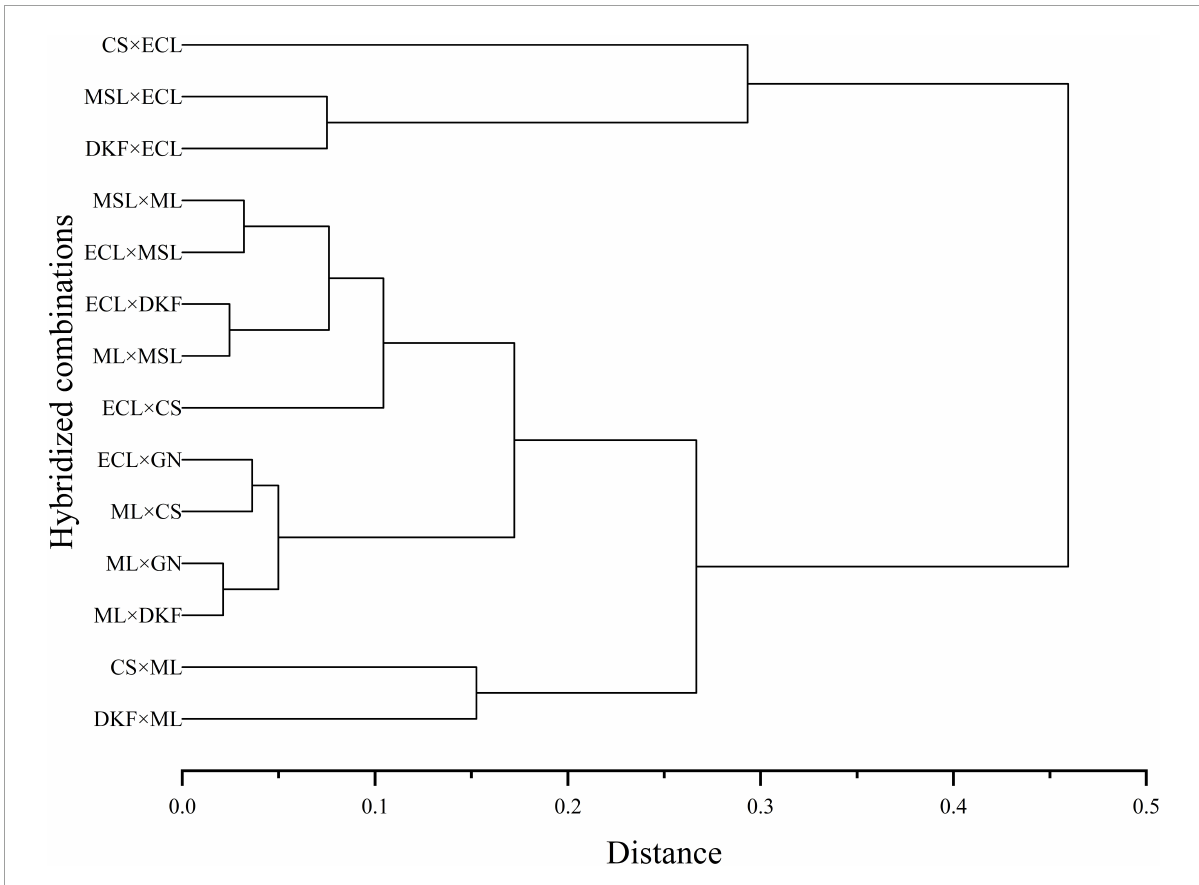
FIGURE6 Systematic cluster analysis diagram of the comprehensive index of fertility of the tested hybrid combinations. For the hybrid combination with Meili as the female parent, only the comprehensive fertility index in 2020 was used for